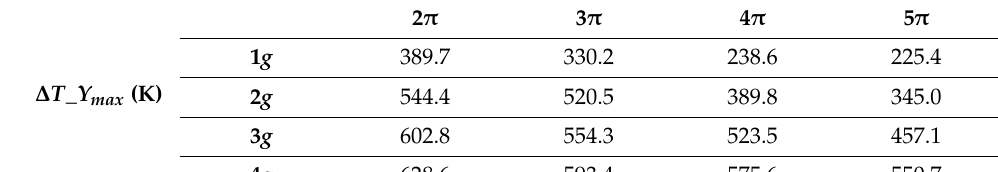
Table 5. ∆ T_Y max values around heater 3.